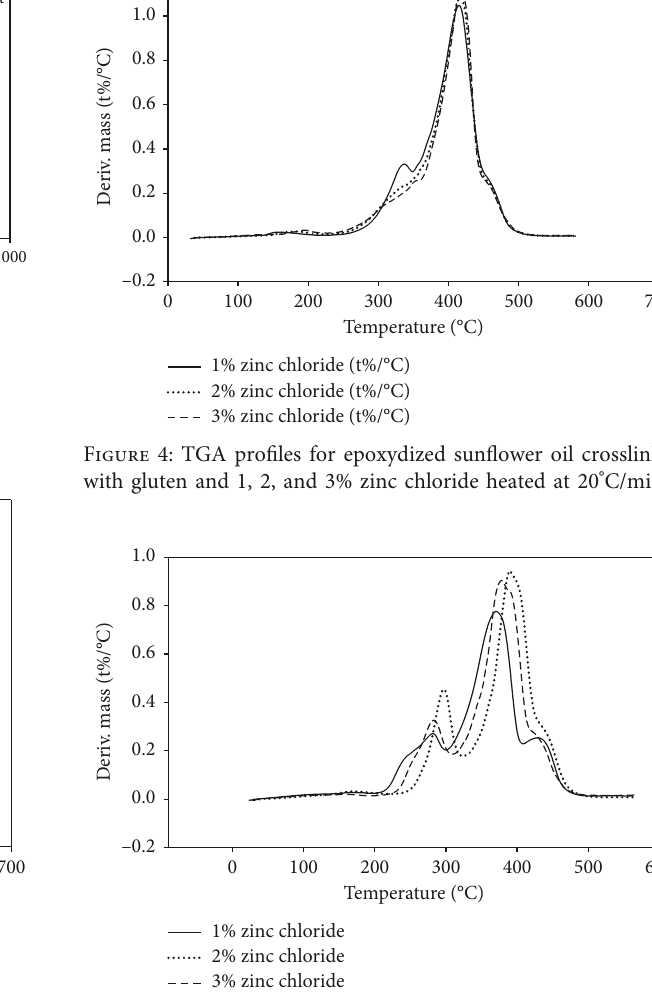
Figure 5: TGA profiles for epoxydized sunflower oil crosslinked with millet and 1, 2, and 3% zinc chloride heated at 20 ° C/min.